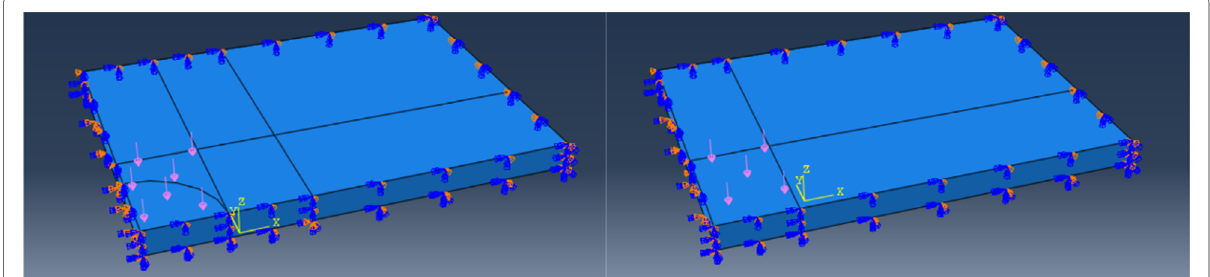
Fig. 2 Model of static simulation when loading was applied on the